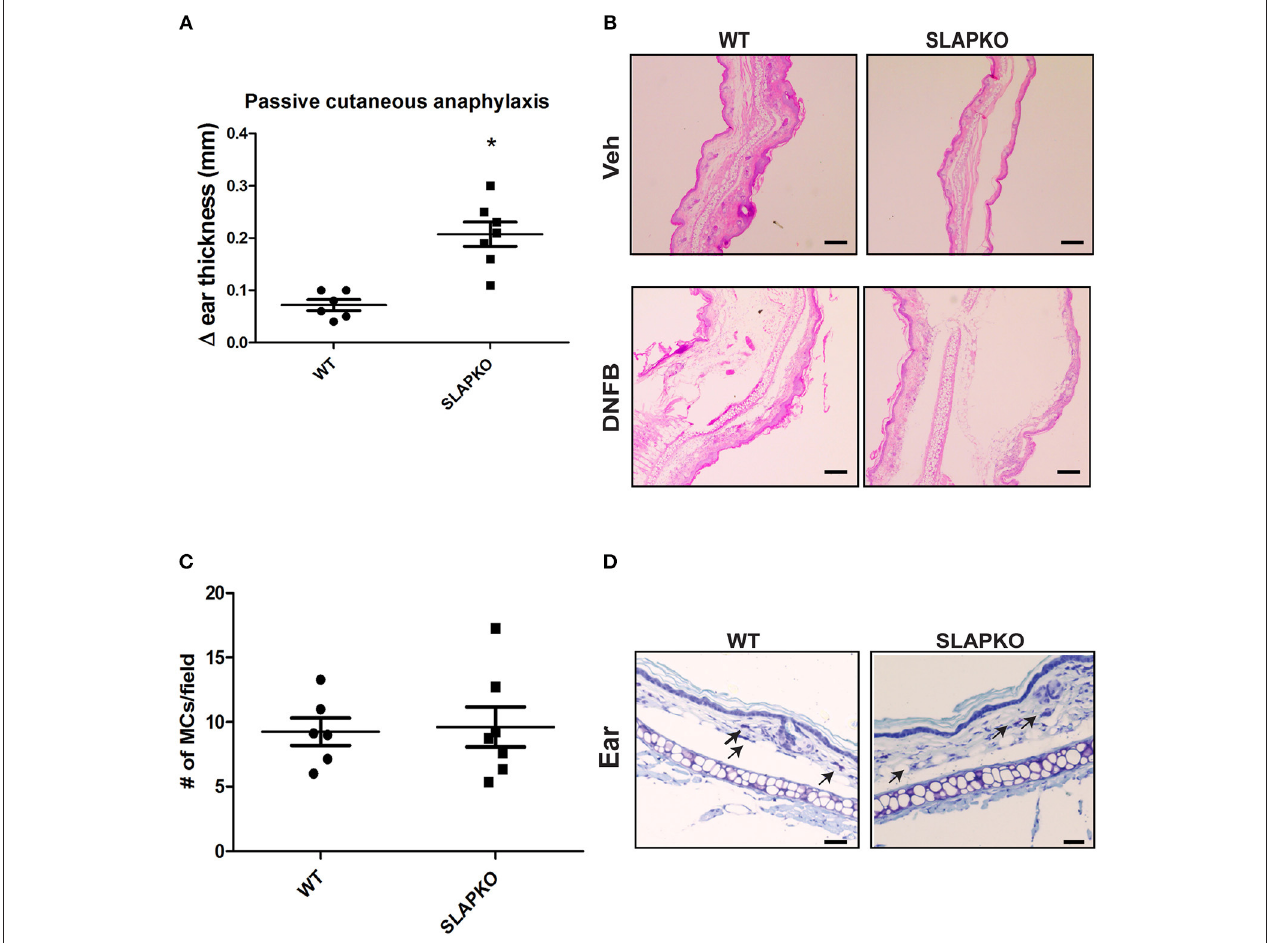
FIGURE 3 | SLAP KO mice show enhanced passive cutaneous anaphylaxis reaction. (A) WT (6 mice) and SLAP KO mice (7 mice) were sensitized by tail vein injection with 2 µ g anti-DNP–IgE 48h prior to topical application of DNFB (0.2% [wt/vol]) to the left ear or vehicle (acetone-olive oil, 4:1) to the right ear. After 24h, mice were culled, and changes in the thicknesses ( 1 ear thickness) of DNFB-treated and vehicle-treated ears were recorded with digital calipers. Dot plot showing pooled data of 1 ear thickness from six WT and seven SLAP KO mice, where each dot represents a data from a single mouse with means as a horizontal line and SD values as vertical line. A significant difference was observed between genotypes (Student’s t -test; * P < 0.05). (B) Representative image of histological section of ear skin from WT and SLAP KO mice treated with either vehicle or DNFB and stained with H&E. Scale bar, 200 µ m. (C) Dot plot representing the pooled data of the average number of mast cells per field (10–15 fields/ear; from six WT and seven SLAP KO mice where each dot represents data from a single mouse). The horizontal lines in the dot plots represent the mean, and vertical lines are SD values calculated from pooled data. No significant difference was observed between the genotypes. (D) Histological section of ear skin from WT and SLAP KO mice were stained with toluidine blue. Mast cells in tissue sections are shown by arrows. Scale bar, 200 µ